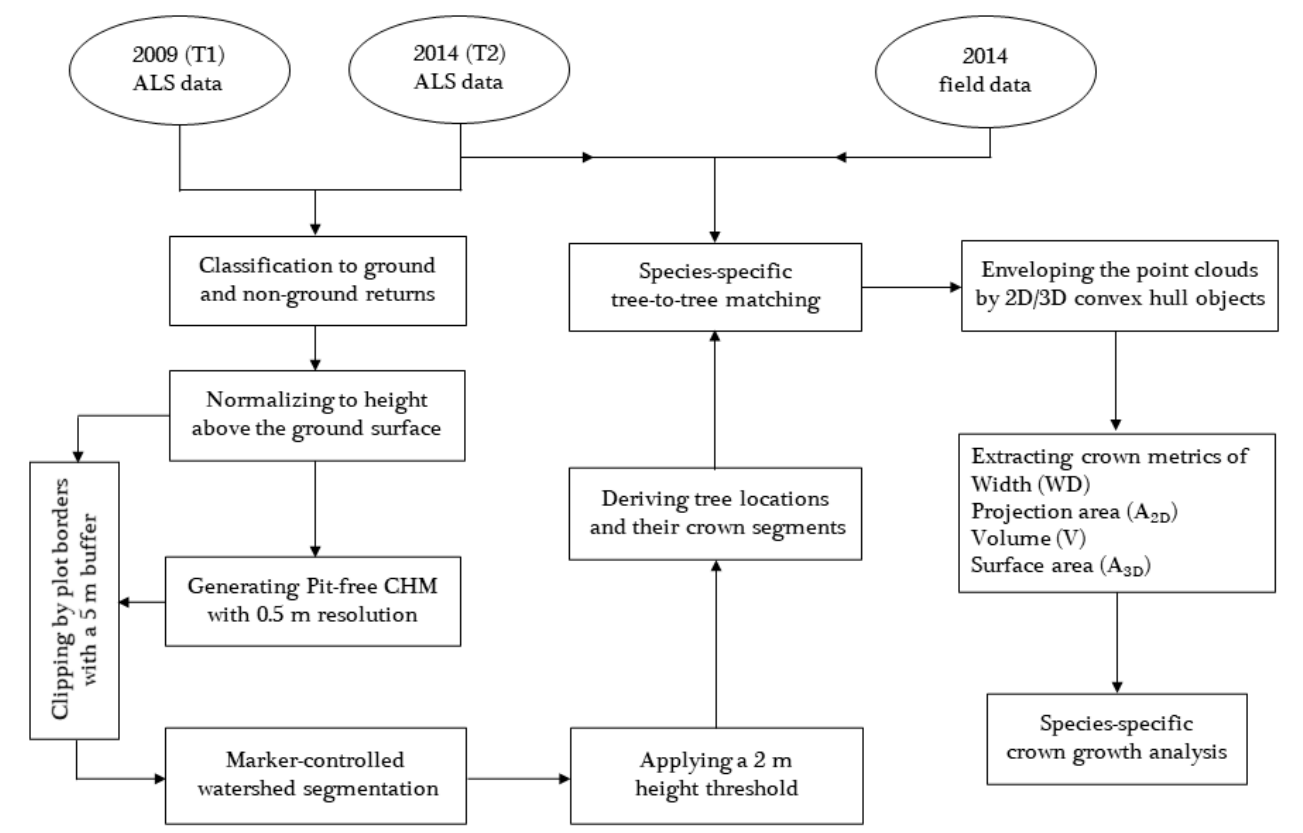
Figure 2. Flowchart of the established monitoring framework.